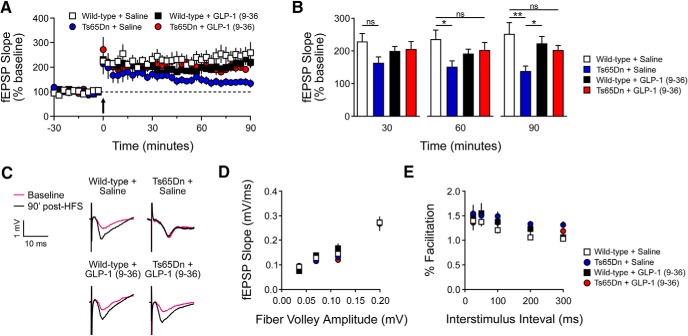
GLP-1 (9-36) treatment rescues hippocampal synaptic plasticity impairments in Ts65Dn mice. A, Acute hippocampal slices from WT+ Saline (n = 9), Ts65Dn + Saline (n = 10), WT+ GLP-1 (9-36) (n = 10), and Ts65Dn + GLP-1 (9-36) (n = 9) mice were stimulated with HFS to induce LTP at the CA3-CA1 synapse. Arrow indicates HFS. Two-way repeated-measures ANOVA revealed significant group (p < 0.05), time (p < 0.05), and group × time (p < 0.001) effects. At 90 min post-HFS, Tukey’s post hoc tests revealed Ts65Dn + Saline had significantly impaired LTP compared with GLP-1 (9-36)-treated Ts65Dn mice (p < 0.05) and saline- and GLP-1 (9-36)-treated WT mice (p < 0.001, p < 0.05). B, Measurement of fEPSP slope at 30, 60, and 90 min after HFS (*p < 0.05, **p < 0.01). C, Representative fEPSP traces at baseline and 90 min post-HFS. D, I/O curves were established by plotting fEPSP amplitudes against fiber volley amplitudes at increasing stimulus intensities in hippocampal slices from WT+ Saline (n = 9), Ts65Dn + Saline (n = 10), WT+ GLP-1 (9-36) (n = 9), and Ts65Dn + GLP-1 (9-36) (n = 9) mice. One-way ANOVA revealed no significant differences between groups at any time point. E, PPF in WT+ Saline (n = 9), Ts65Dn + Saline (n = 10), WT+ GLP-1 (9-36) (n = 9), and Ts65Dn + GLP-1 (9-36) (n = 9) mice. One-way ANOVA revealed no significant differences between groups at any time point.